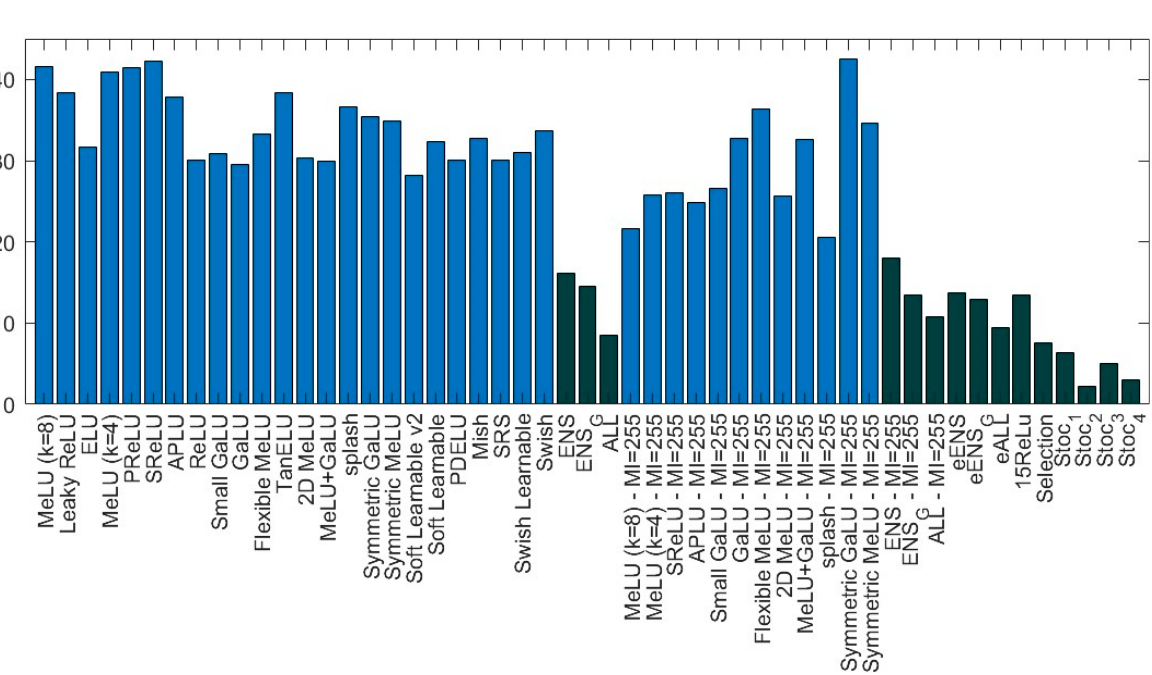
Figure 5. Average rank (lower is better) obtained by different AFs and ensembles coupled with ResNet50 (light blue represents stand-alone methods and dark blue, ensembles).